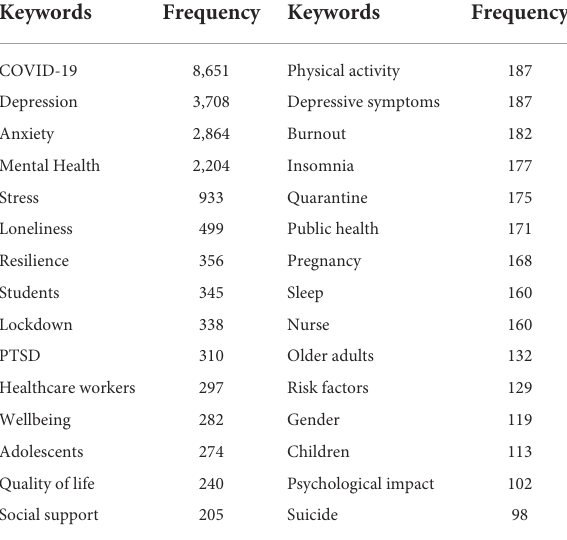
TABLE 7 Top 30 highest frequency keywords related to depression during